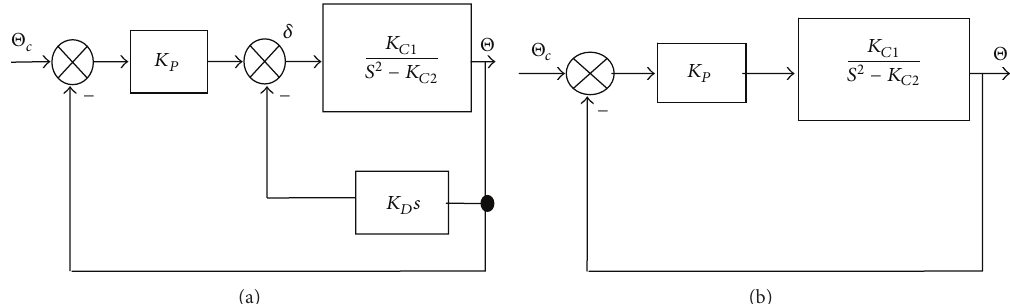
Figure 3: Structure of an attitude control system of a space launch vehicle (a) and an example of structural changes (b).